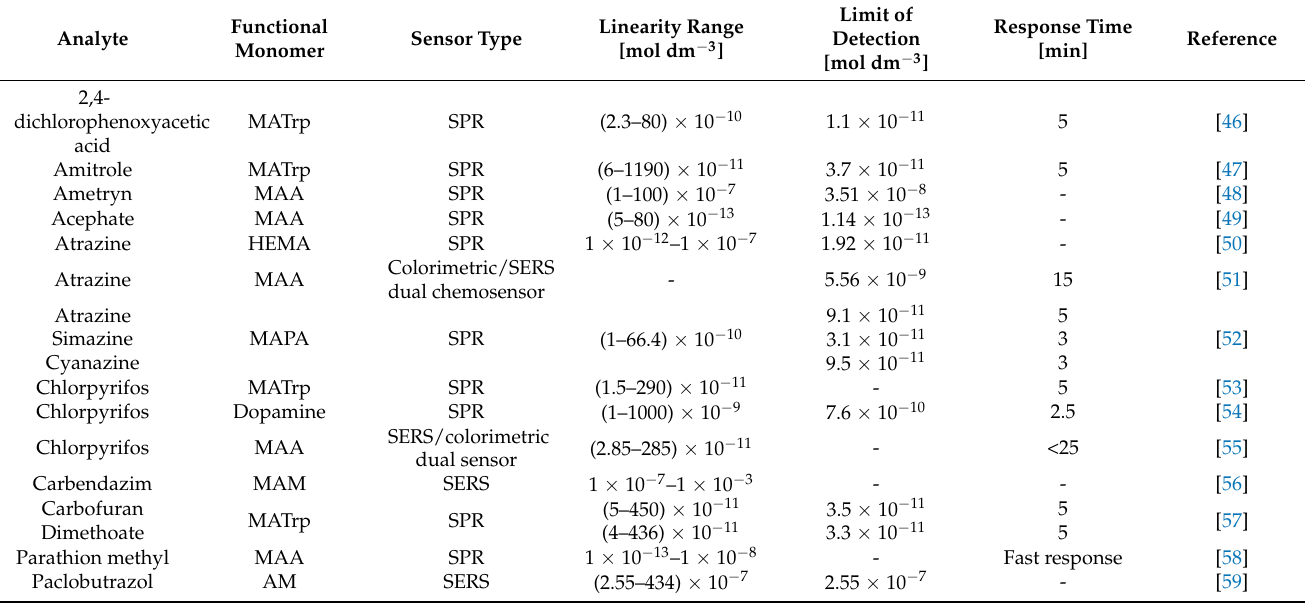
Table 1. MIP-based plasmonic sensors for different pesticide detection and their most important